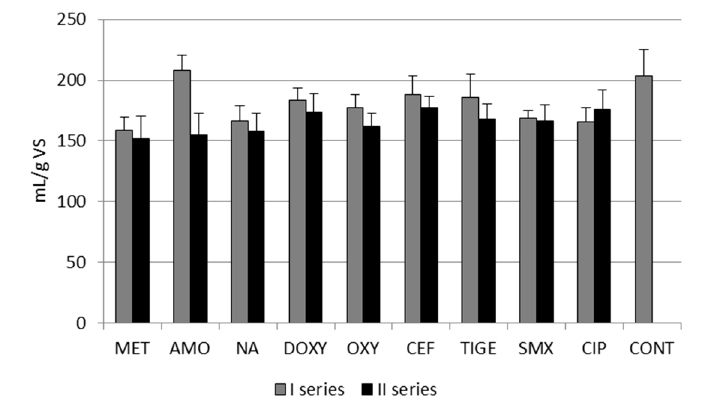
Figure 1. Biogas production from sewage sludge with antibiotic addition. Abbreviations: MET— metronidazole, AMO—amoxicillin, NA—nalidixic acid, DOXY—doxycycline, OXY—oxytetracycline, CEF—cefuroxime disodium salt, TIGE—tigecycline, SMX—sulfamethoxydiazine, CIP—ciprofloxacin, CONT—control.